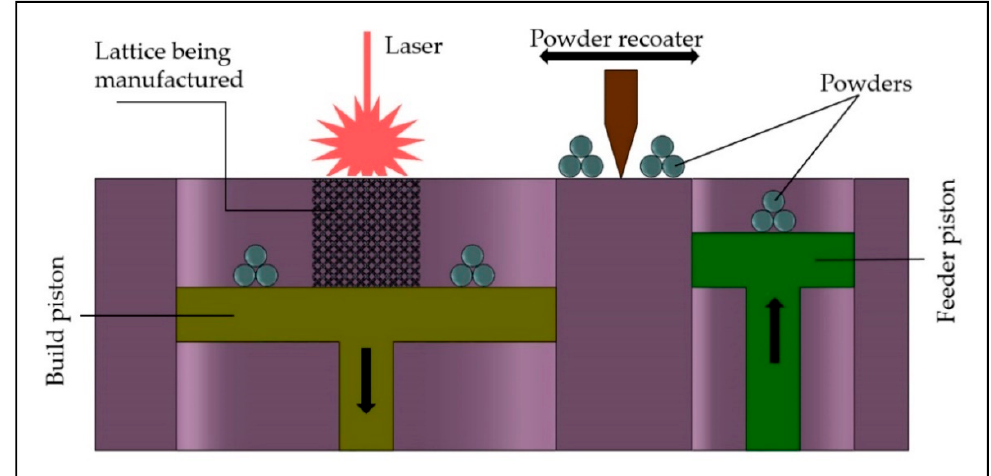
Figure 2. Schematic of selective laser melting device (SLM, SolidWorks design).